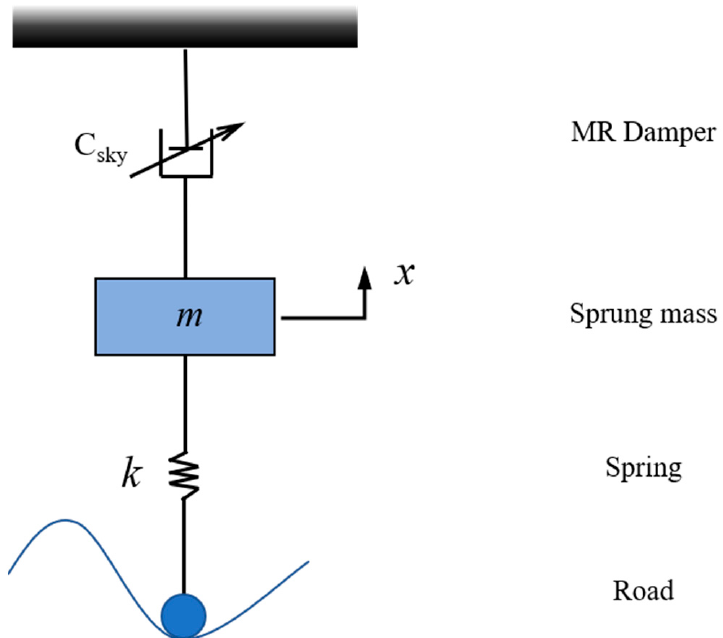
Figure 2. Semi ‐ active system with a skyhook controller [18]. Reproduced with permission from Figure 2. Semi-active system with a skyhook controller [18]. Reproduced with permission from Choi, S. ‐ B. and Han, Y. ‐ M., Magnetorheological Fluid Technology: Applications in Vehicle Sys ‐ Choi, S.-B. and Han, Y.-M., Magnetorheological Fluid Technology: Applications in Vehicle Systems; published by CRC Press, 2013. tems; published by CRC Press, 2013.